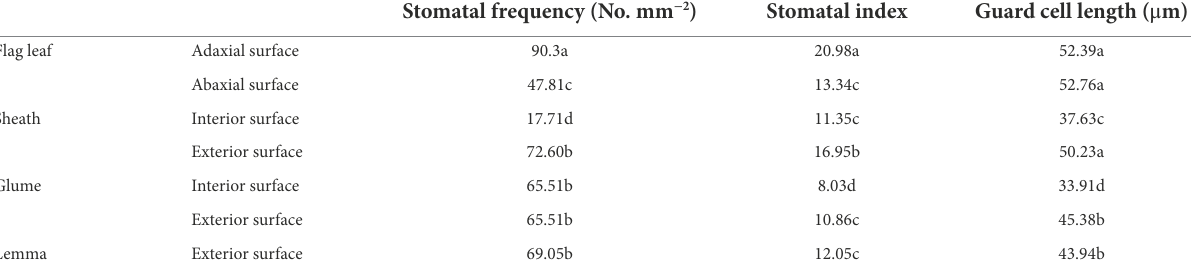
Different small letters within the same column meant a significant difference at the 0.05 probability